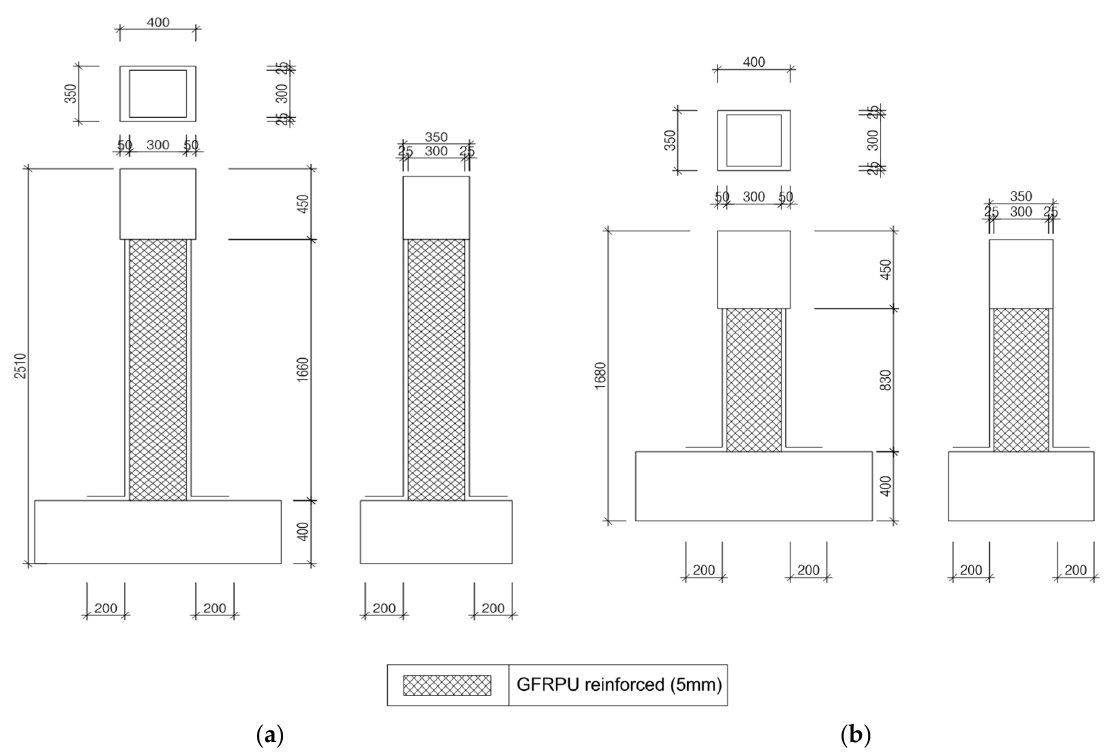
Figure 2. Reinforcement of GFRPU of ( a ) H-series and ( b ) S-series (unit: mm).